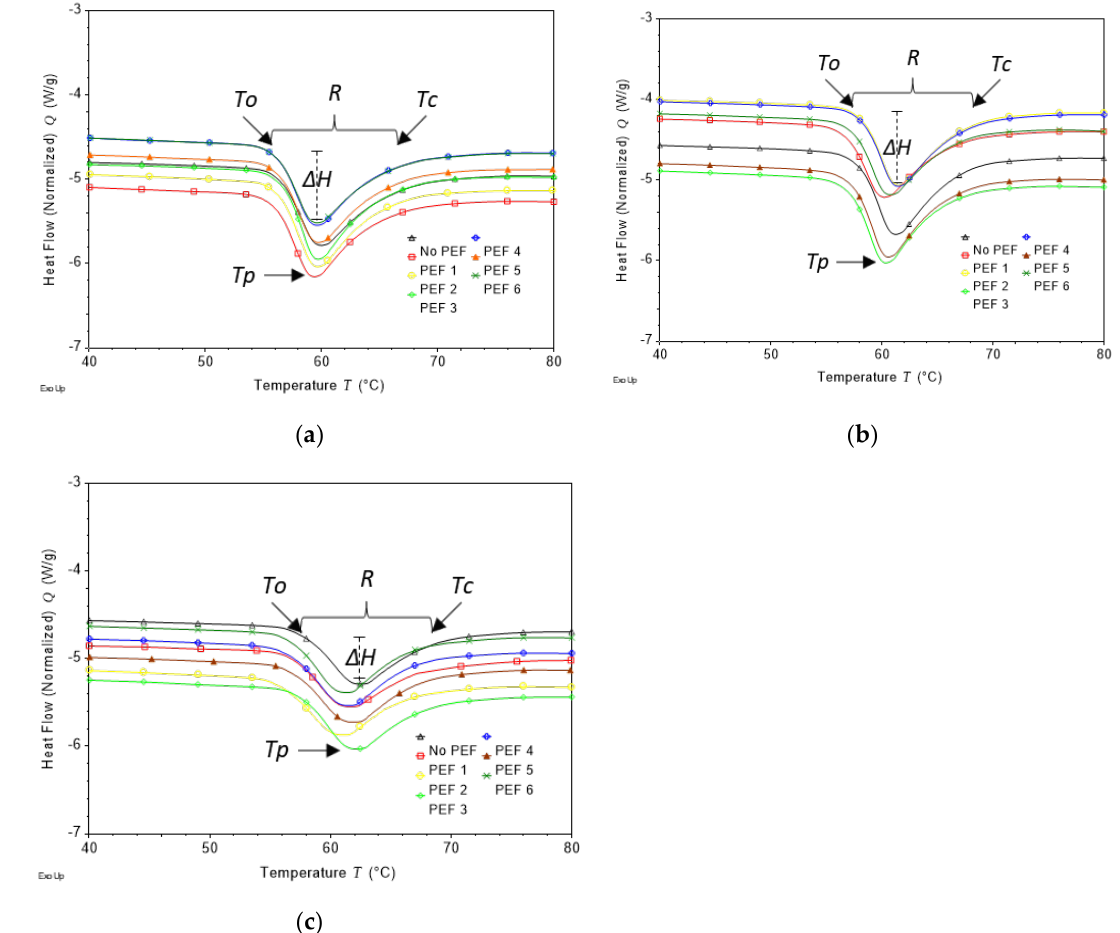
Figure 5. DSC thermograms of isolated starch ( a ), starch from processing medium ( b ), and potato powder ( c ) from untreated (No PEF) and PEF-treated potatoes at 50 kJ/kg specific energy with field strengths (kV/cm) of 0.5 (PEF 1), 0.7 (PEF 2), 0.9 (PEF3), 1.1 (PEF 4) and at 150 kJ specific energy with field strength (kV/cm) of 0.7 (PEF 5) and 0.9 (PEF 6). To : temperature of onset gelatinisation, Tp : temperature of peak gelatinisation, Tc : temperature of conclusion gelatinisation, R : gelatinisation temperature range, ΔH : enthalpy change of gelatinisation.